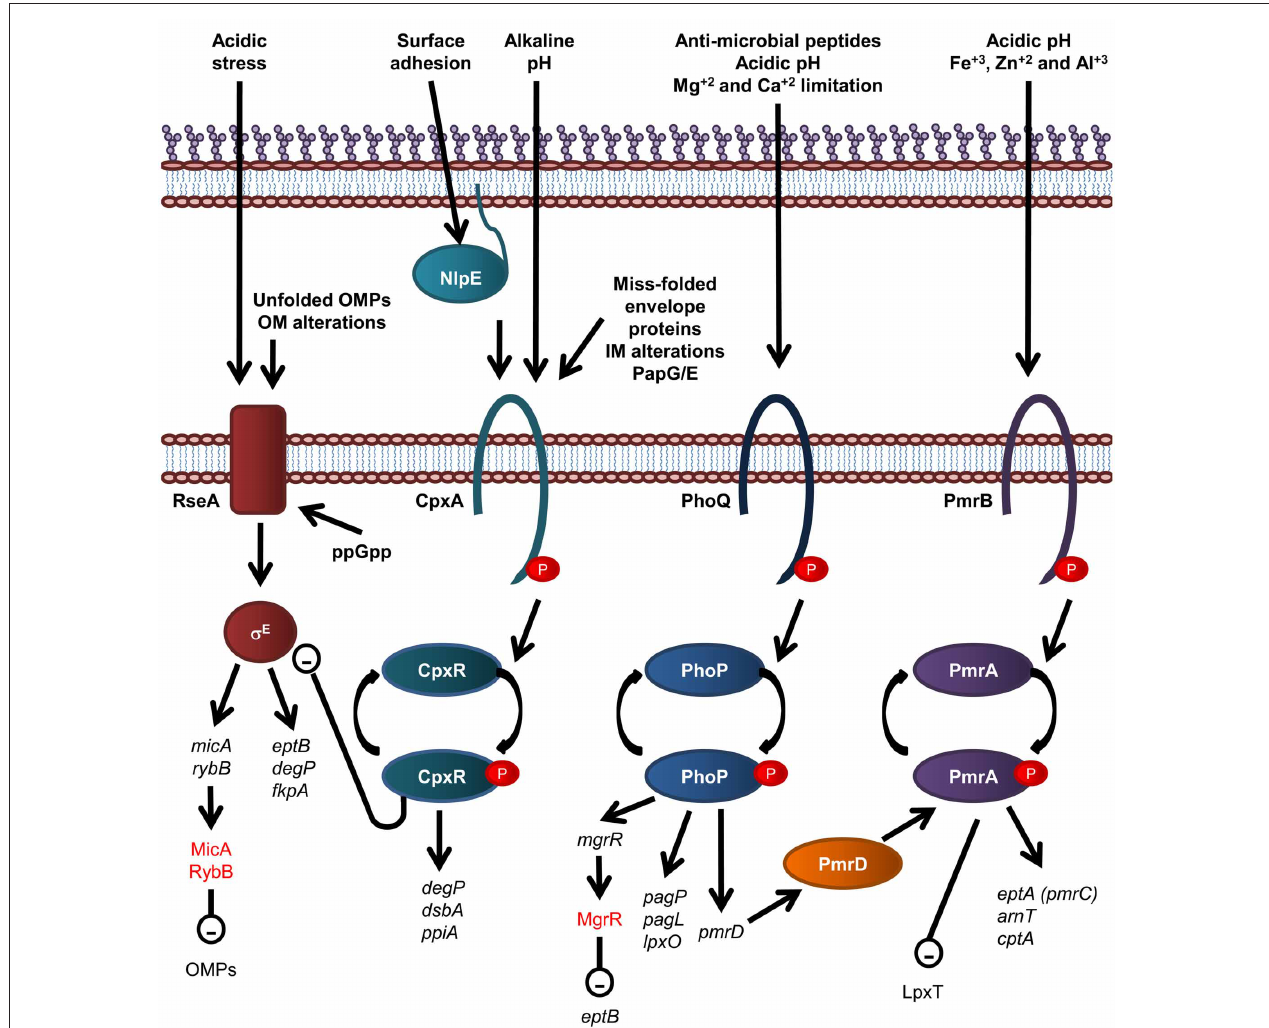
FIGURE 4 | Overview of regulatory systems involved in LPS biogenesis and periplasmic protein folding in E. coli. The sensor histidine kinase and cognate response regulator protein of each of the CpxR/A, PhoP/Q, and PmrA/B two component systems are shown. The σ E envelope stress response is also shown, where σ E activation is inversely related to